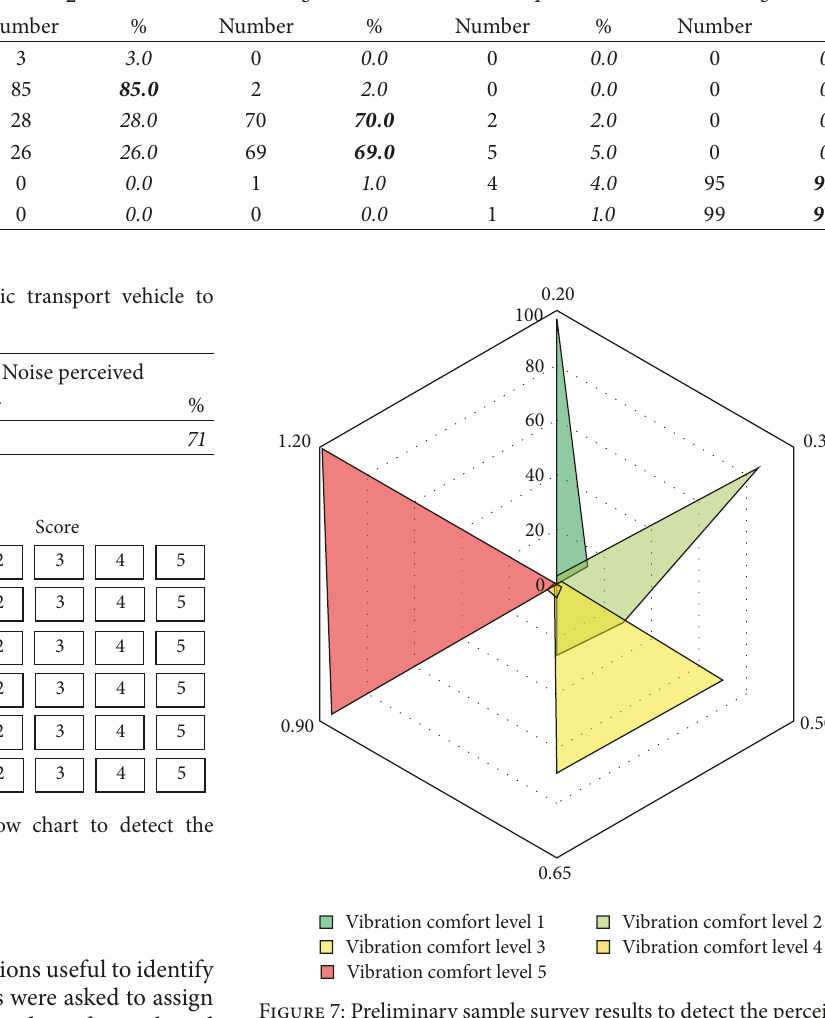
Figure 7: Preliminary sample survey results to detect the perceived vibration